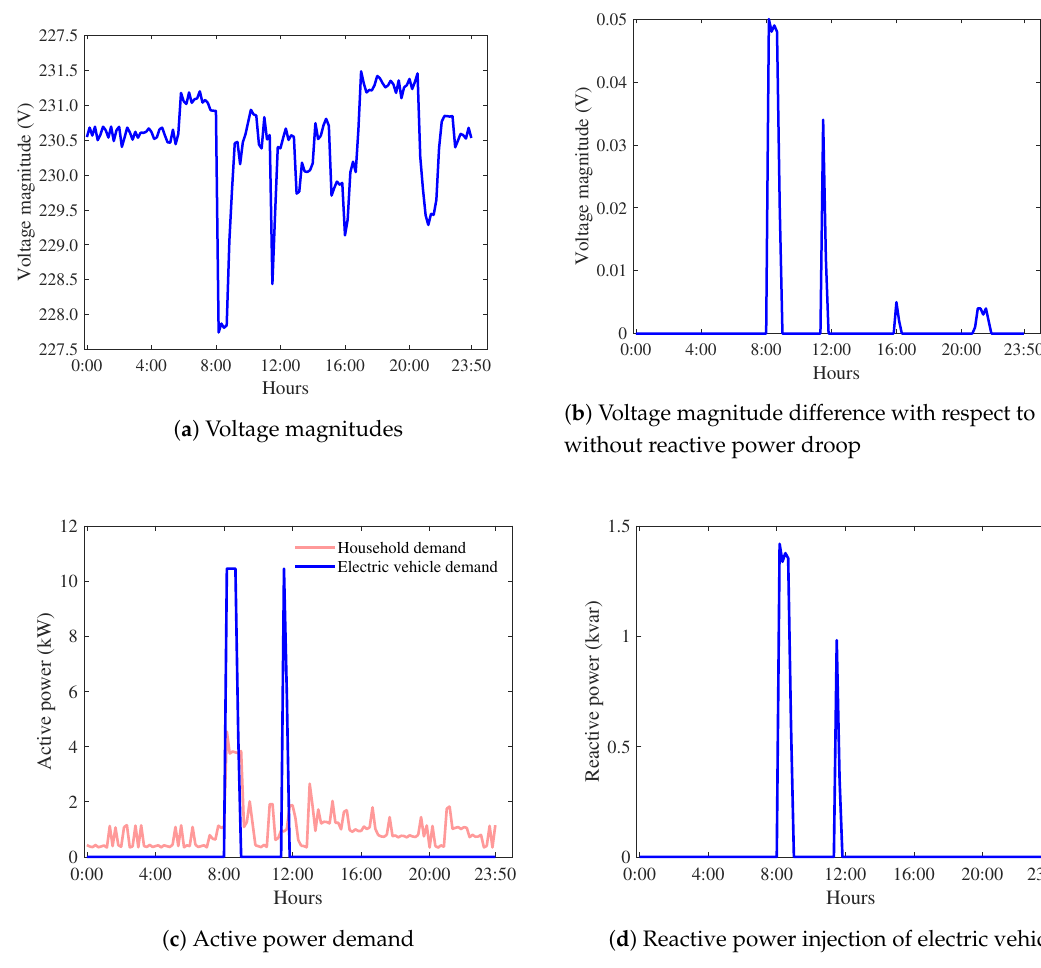
Figure 10. Case study: Results bus 10 (11 kVA- E 1